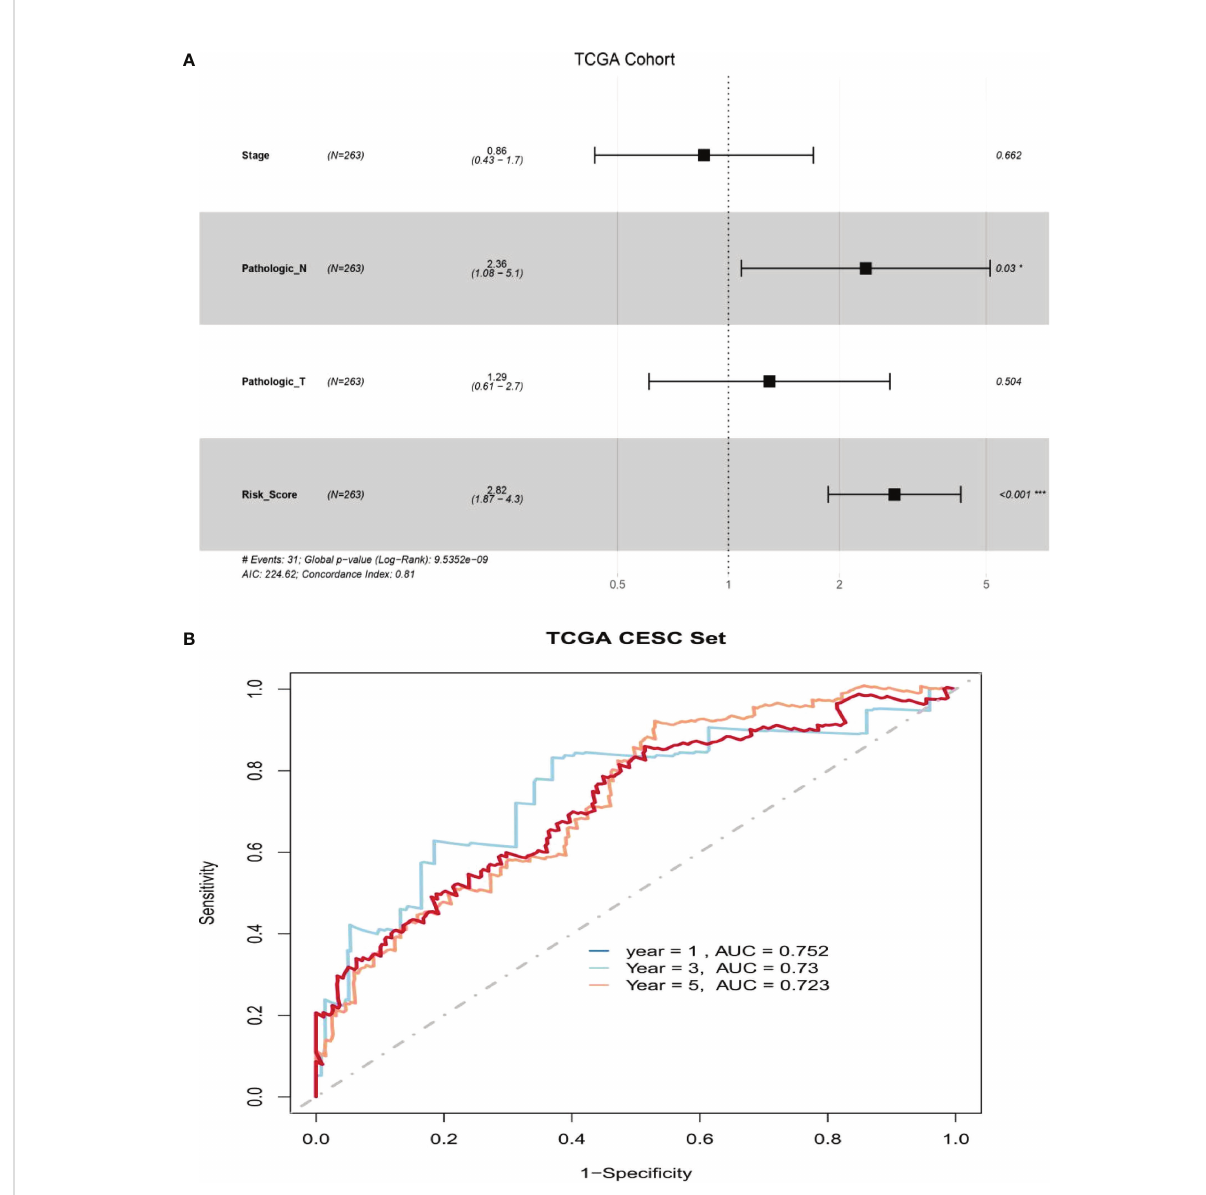
FIGURE 5 There was great predictive performance of the prognostic indicators based on ARLs. (A) Forest plots which represented the results of the multivariate Cox regression analysis in cervical squamous cell carcinoma. (B) The areas were respectively 0.752, 0.730, and 0.723, which were under the ROC curve corresponding to 1, 3, and 5 years of